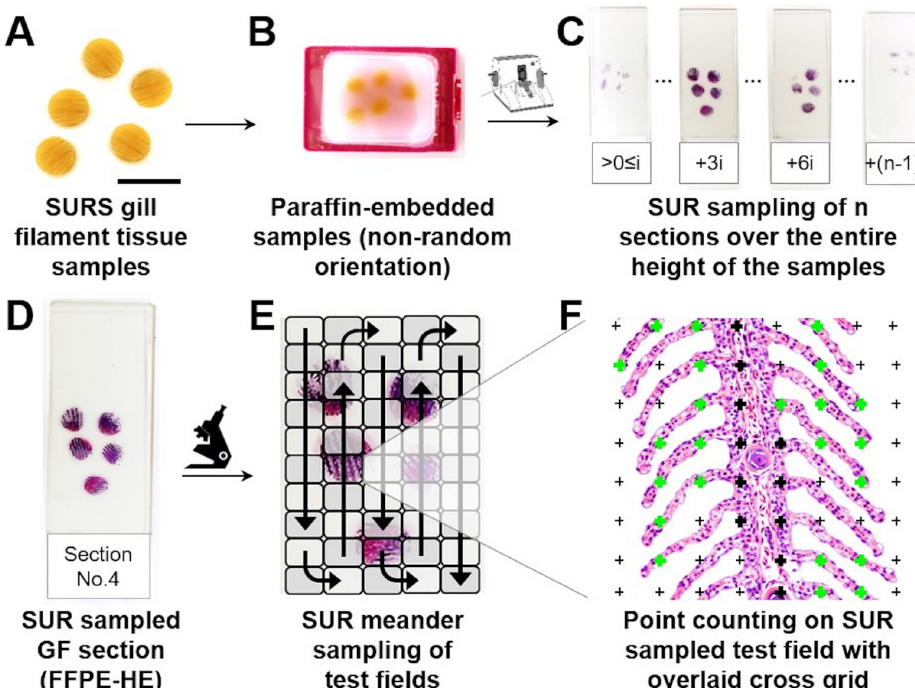
Fig 12. Estimation of the volume density of the secondary lamellae in the gill filaments. A. SUR sampled GF specimens (please compare to Section 9 ). B, C. SUR sampling of sections from samples embedded in paraffin in non-random orientation. B. Paraffin block with sagittally embedded GF samples. C. SUR sampling of sections. The entire block is exhaustively sectioned. For subsequent analyses, sections are taken in a defined sampling interval (i). The first section is randomly taken within the sampling interval ( > 0 � i). D-G. Estimation of V V(SL/GF) by point counting. D. SUR sampled section of GF specimens. E. SUR sampling of test fields within the section, performed at a factor of magnification allowing for a reliable differentiation of PL and SL ( e . g ., 40x-100x microscopic magnification). All sampled sections per case are entirely screened, following a defined meander pattern and test fields are SUR sampled in a defined interval i ( i . e .,every i th field of view containing GF section profiles), with the first field of view being randomly selected within the sampling interval. F. SUR sampled test field overlaid with an appropriately sized cross grid (here: 8x8 points at 100x microscopic magnification). The number of points hitting GF section profiles (P (GF) , indicated by bold crosses) in all sections per case are counted, as well as the number of points hitting SL section profiles (P (SL) , indicated by green crosses). 34 points hit the entire GF section profile, 23 points hit the SL section profile. V V(SL/GF) is calculated as the point density of P (SL) and P (GF) . The total SL volume (V (SL,GF) ) is calculated as the product of V V(SL/GF) and the GF volume V (GF)